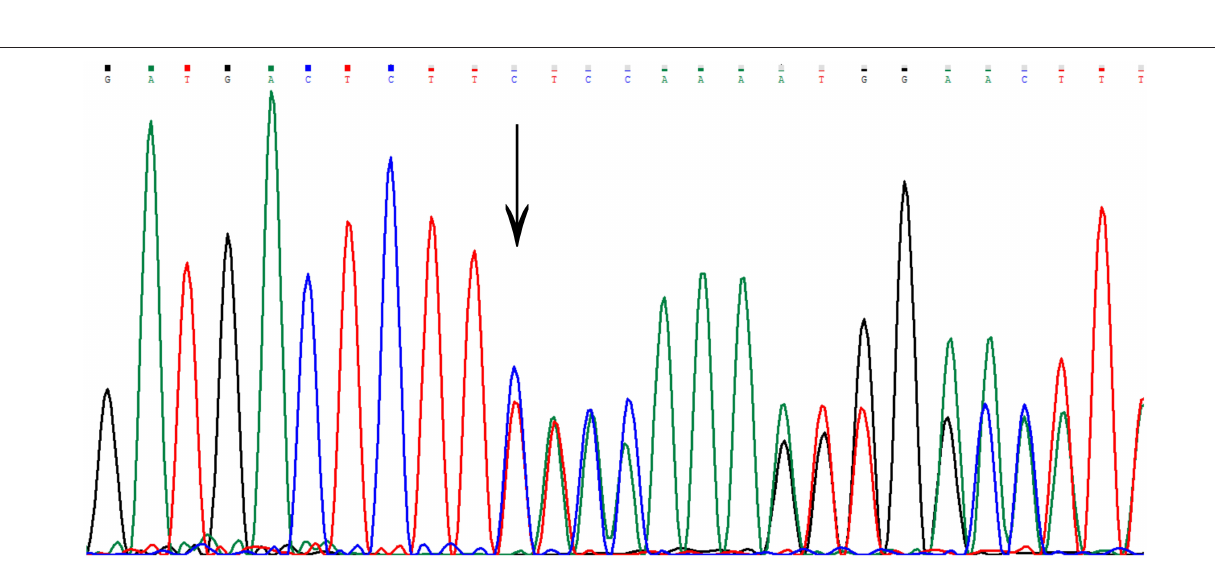
FIGURE 3 | The genetic variant of c.755delC. The arrow indicates the deletion of a nucleotide at that site. There is a frameshift downstream of the deletion